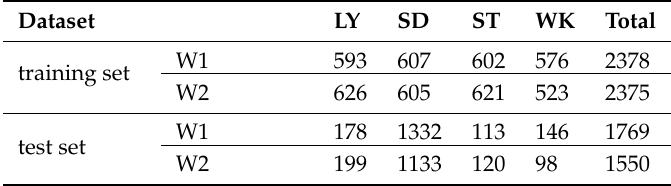
Table 1. Number of time segments in the training and test sets.